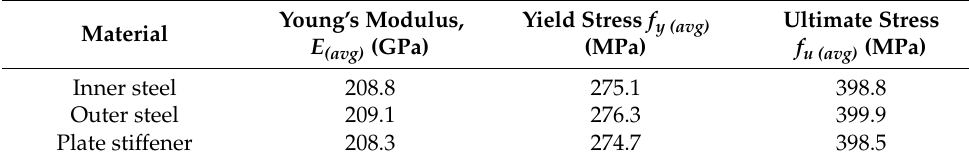
Table 4. Mechanical properties of the steel